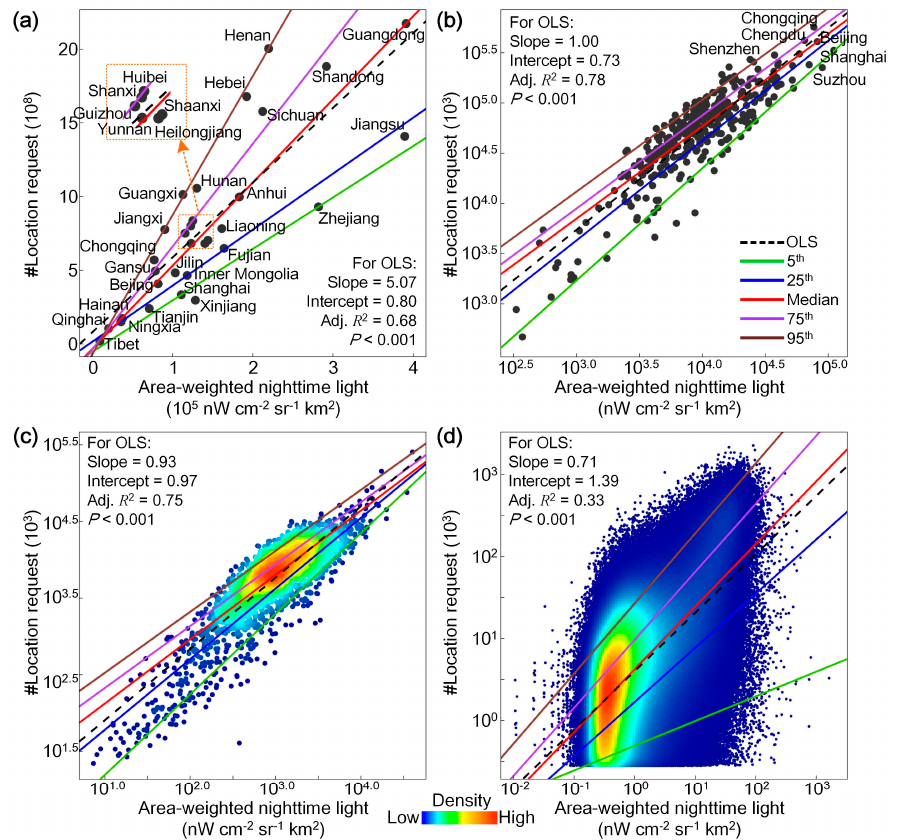
Figure 3. Quantitative relationship between the area-weighted nighttime light radiances and the number of location requests estimated by ordinary least square (OLS) and quantile regression at four different levels: ( a ) the provincial level (linear scale, samples = 31); ( b ) the city level (log-linear scale, samples = 340); ( c ) the county level (log-linear scale, samples = 2852); and ( d ) the pixel level (log-linear scale, samples = 1,870,364). All quantile regressions show statistical significance with P < 0.001.